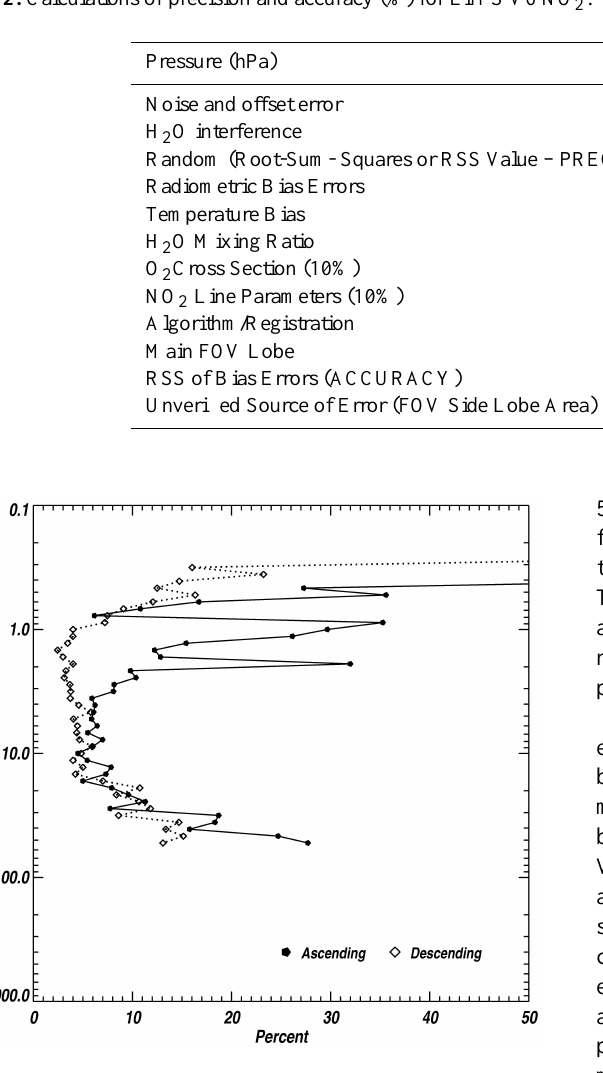
Table 2. Calculations of precision and accuracy (%) for LIMS V6 NO 2 . Pressure (hPa)